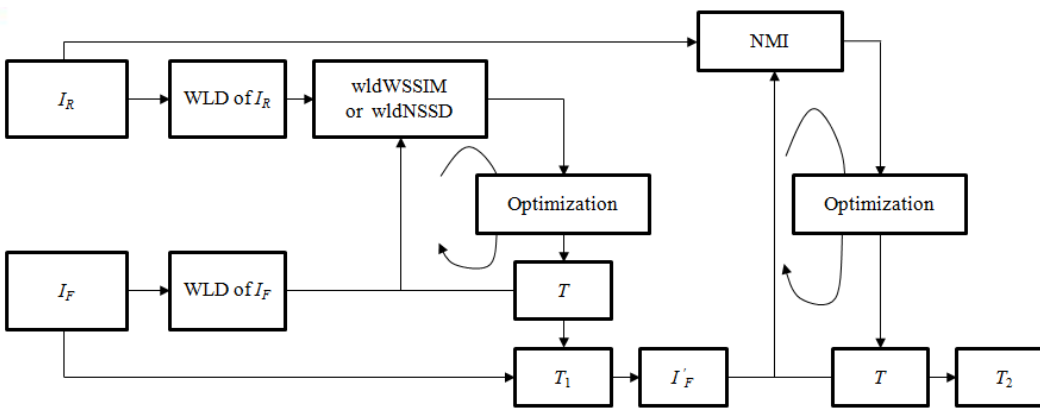
Figure 1. Two phase non-rigid multi-modal image